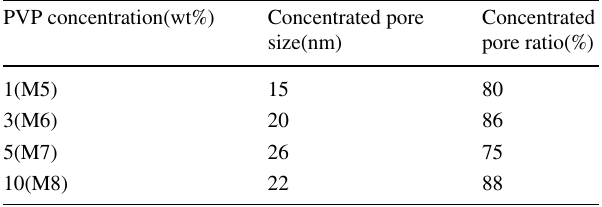
Table 5 Pore size distribution of PVDF membranes with different PVP concentrations